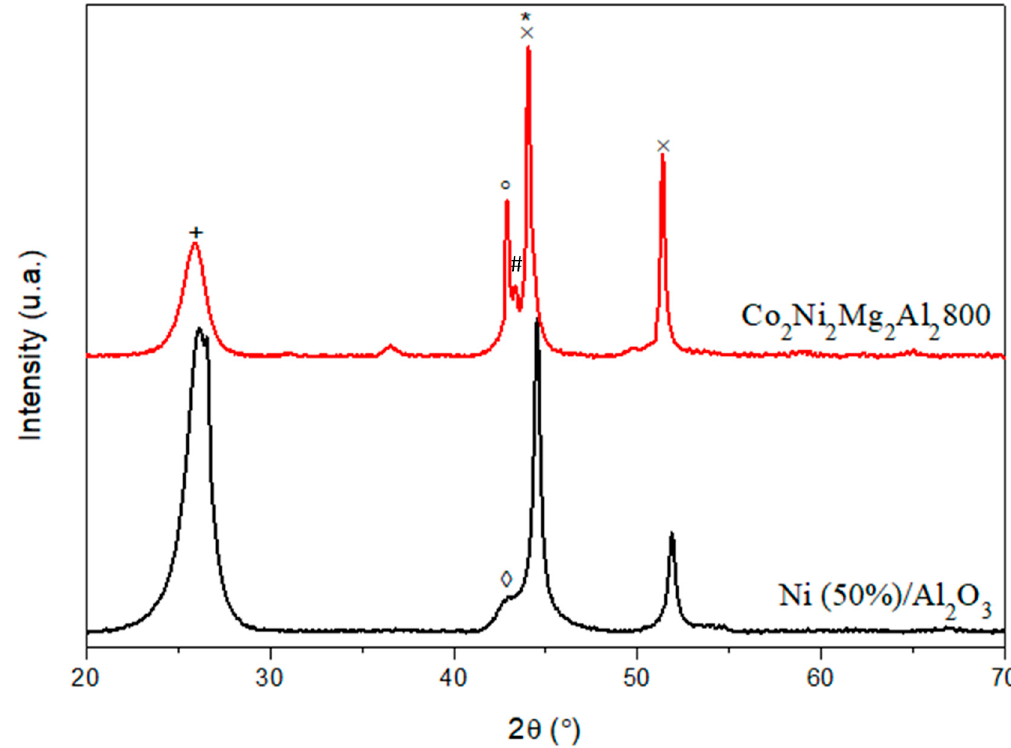
Figure 2. X-ray diffraction (XRD) patterns of Co 2 Ni 2 Mg 2 Al 2 800 and the commercial catalyst Ni (50%) / Al 2 O 3 after DRM test (* C cubic JCPDS N ◦ 800017; + C hexagonal JCPDS N ◦ 751621; # Co 2 AlO 4 JCPDS N ◦ 380814 / CoAl 2 O 4 JCPDS N ◦ 440160 / Co 3 O 4 JCPDS N ◦ 421467; × Co JCPDS N ◦ 150806 / Ni JCPDS N ◦ 211152; ◦ MgO JCPDS N ◦ 450946; ♦ NiAl 2 O 4 JCPDS N ◦ 100339 / Al 2 O 3 JCPDS N ◦ 10173).